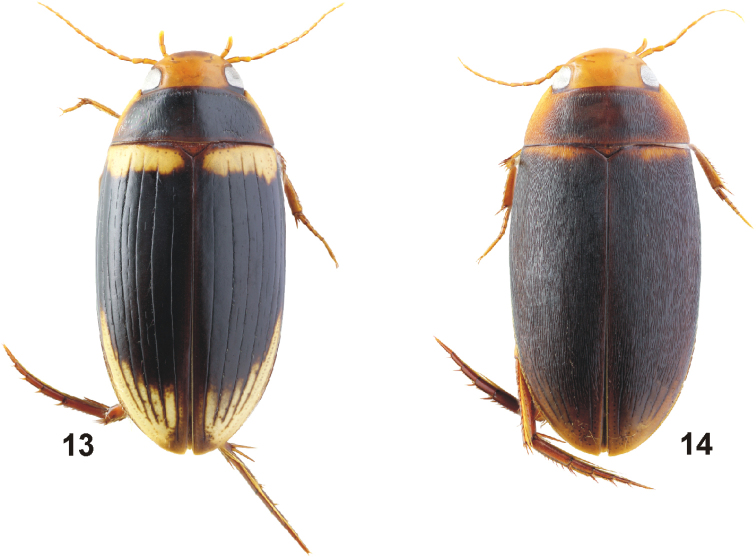
Habitus of Copelatus13Copelatus sp. 1 14Copelatus sp. 2.